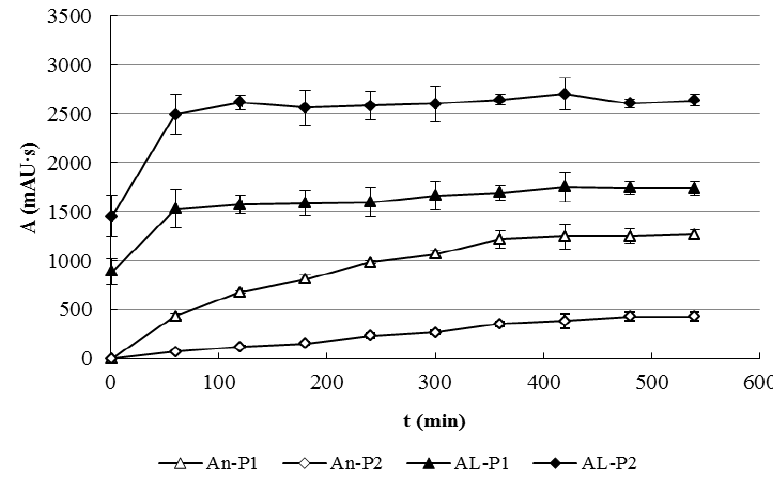
Figure 7. Comparison of Products in the Reactions of AL-1 and Andro with GSH (n = 3). An-P1, An-P2, AL-P1 and AL-P2 represented P1 and P2 in the Andro and AL-1 reaction system,